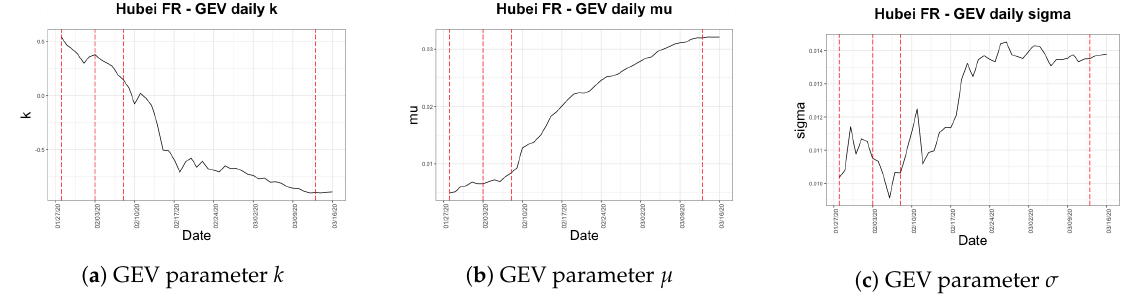
Figure 12. Time series for Hubei fatality ratio GEV